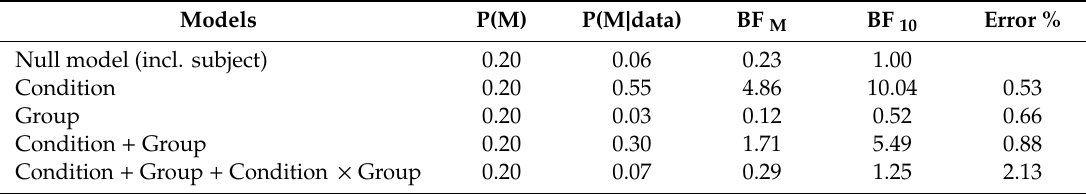
Table 4. 2 × 3 Bayesian ANOVA for MI intensity (two levels: single-gain , competitive-gain ; three levels: training, single, and competitive multi-user